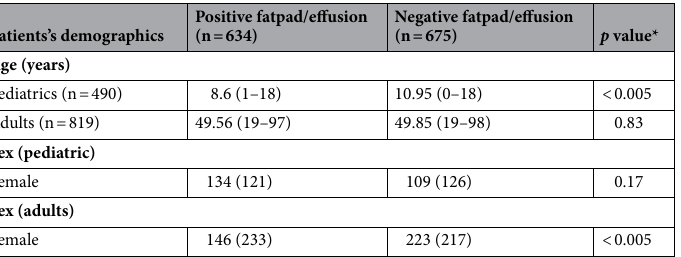
Table 1. Patient demographics in pediatric and adults groups (from the main data registry). *Two-sample t-test significant test.